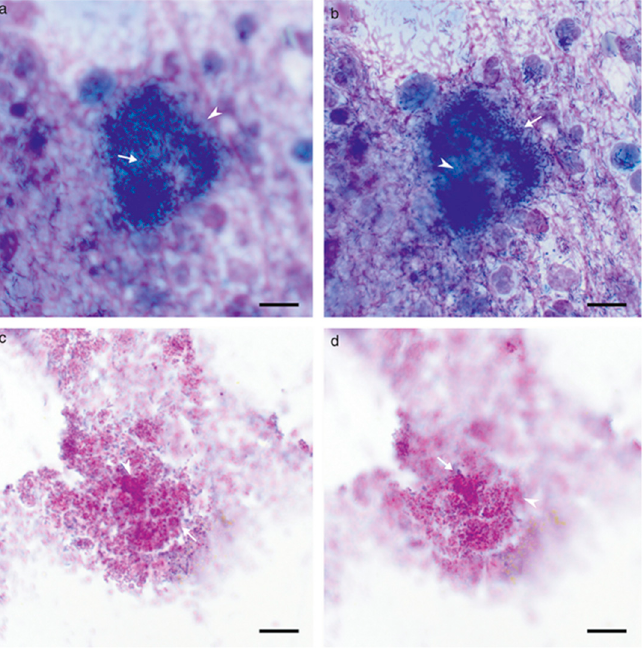
Figure 2. Comparison of bacterial aggregates across two focal planes from slides assessed to have aggregate-associated infection. In-focus microorganisms are indicated with white arrows; out-of-focus microorganisms indicated with the white arrowheads. Note the difference in the focus of organisms across focal planes. Microorganisms are high-density and clustered within a well-defined stained matrix, versus organisms on the periphery, which are not associated with the matrix. Both samples are from the same ear. ( a , b ) modified Wright’s stain, ( c , d ) periodic acid-Schiff stain. ( a – d ) 100 × (oil) objective, bar = 10 µ m. Reprinted from [20], Copyright (2021), with permission from John Wiley and